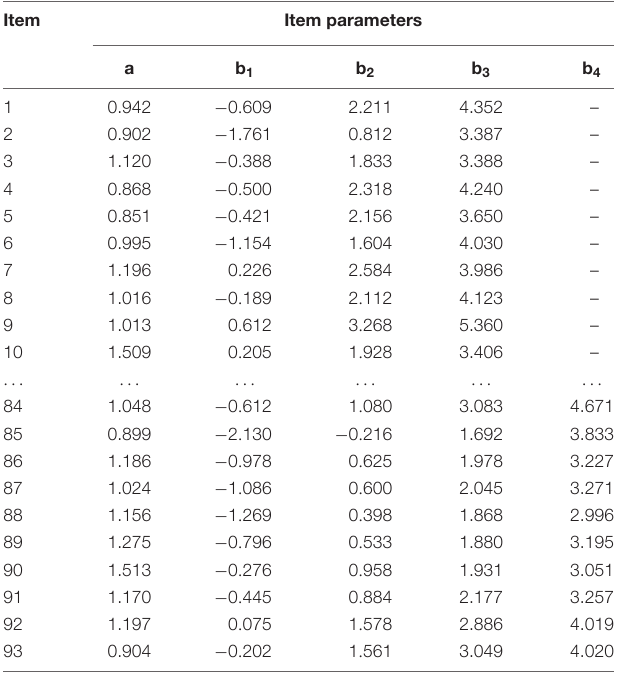
TABLE 1 | Estimated GRM parameters of a 20-item example from the final stress item bank (93 items). Item Item parameters